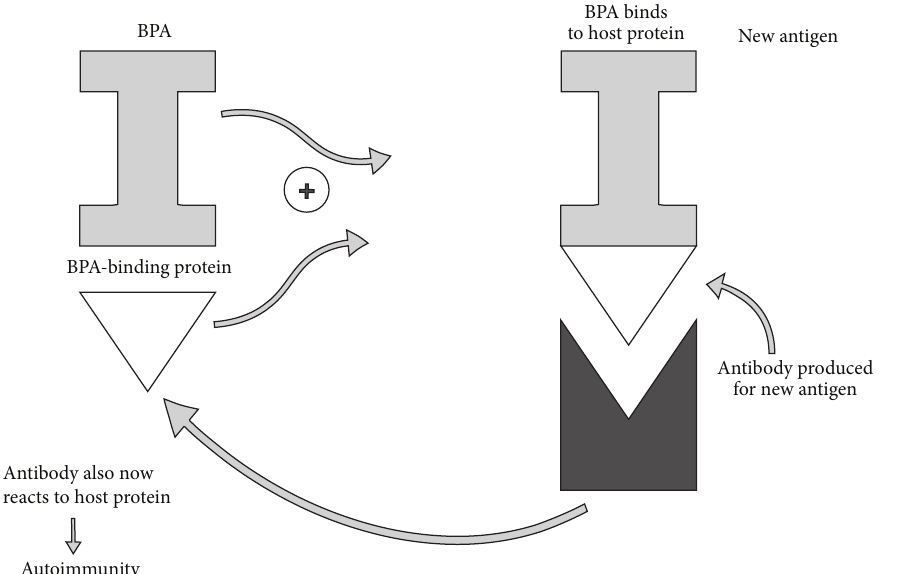
Figure 10: This diagram illustrates how bisphenol A can bind to the host protein, leading to a new epitope reaction against the host protein, resulting in autoimmunity. BPA: bisphenol